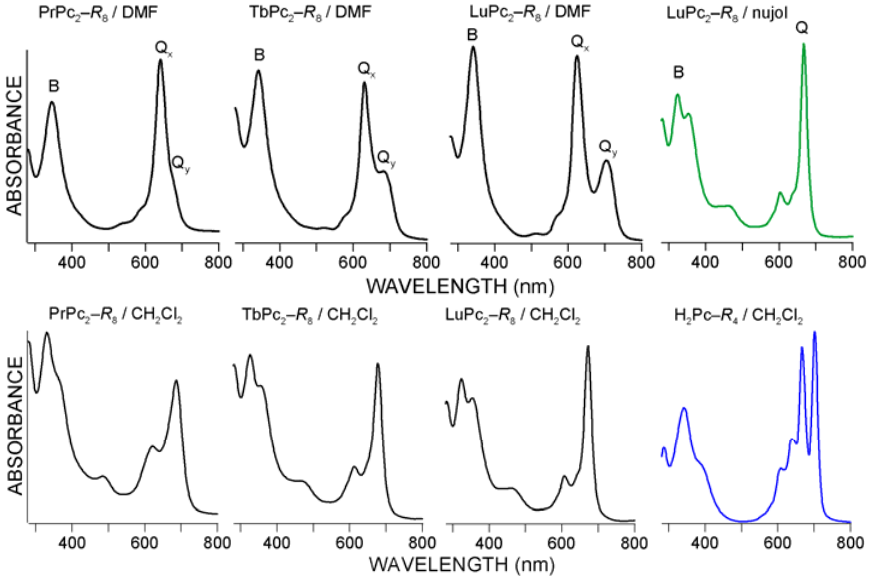
in DMF and 2 Pc- R ; for λ details see Table 2 4 max